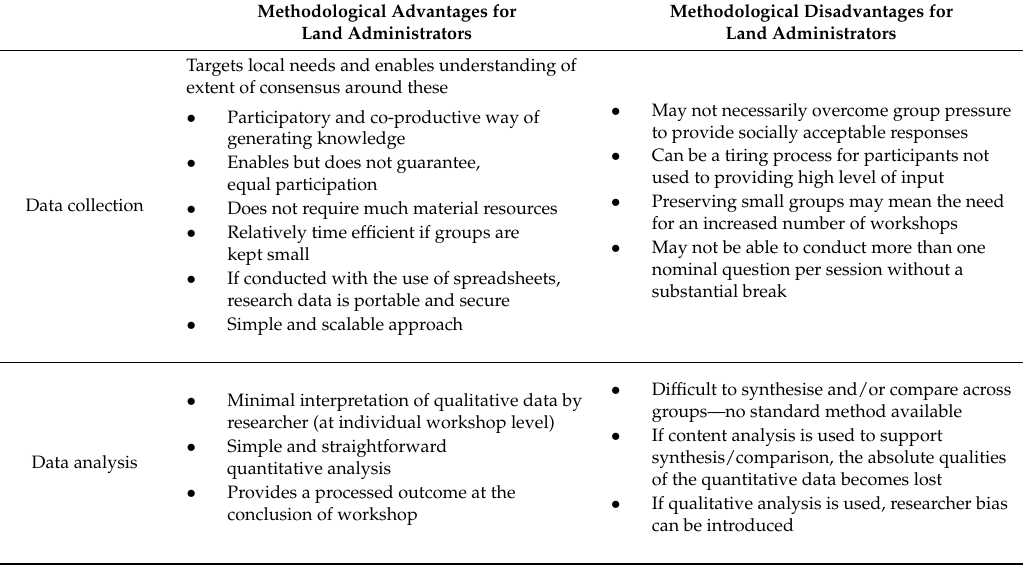
Table 7. Overview of using NGT as a method for needs assessment in land